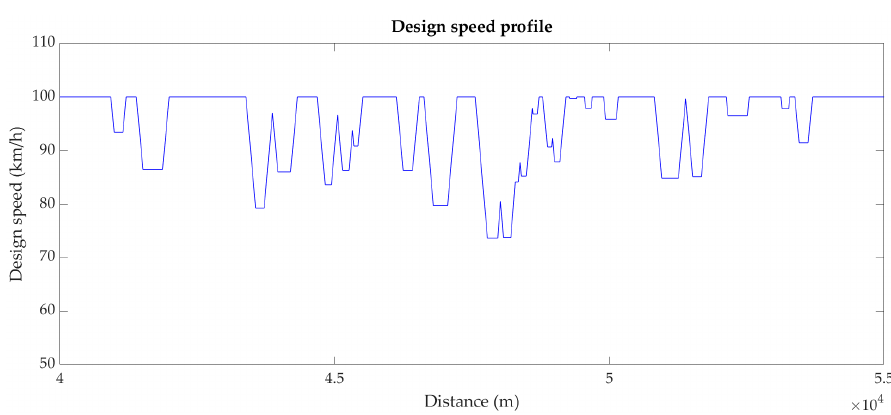
Figure 14. Design speed profile of the HWY 4—from the distance 40 km to the distance 55 km.